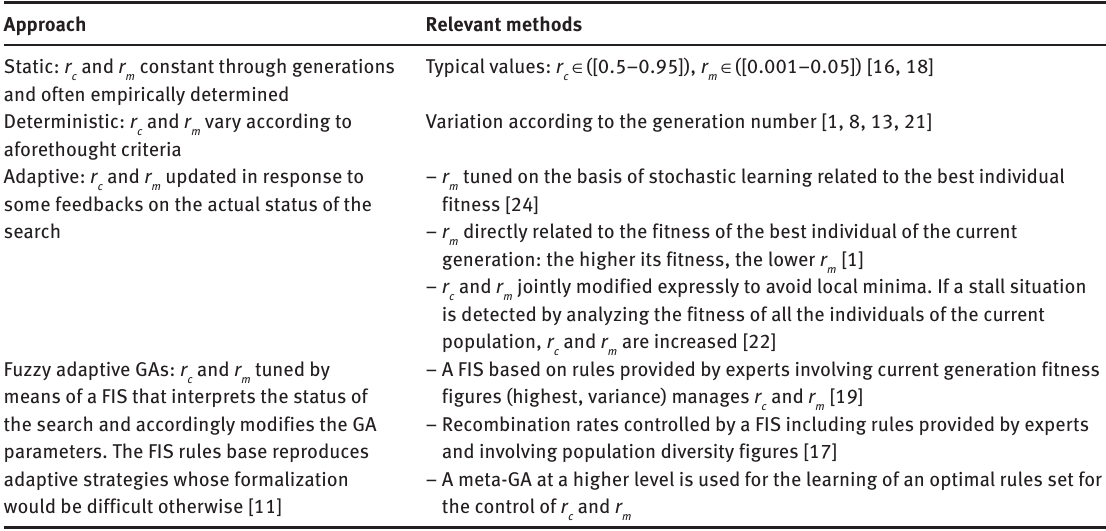
Table 1: Summary of Approaches and Relevant Methods for the Control of Recombination Rates within GAs. Approach Relevant